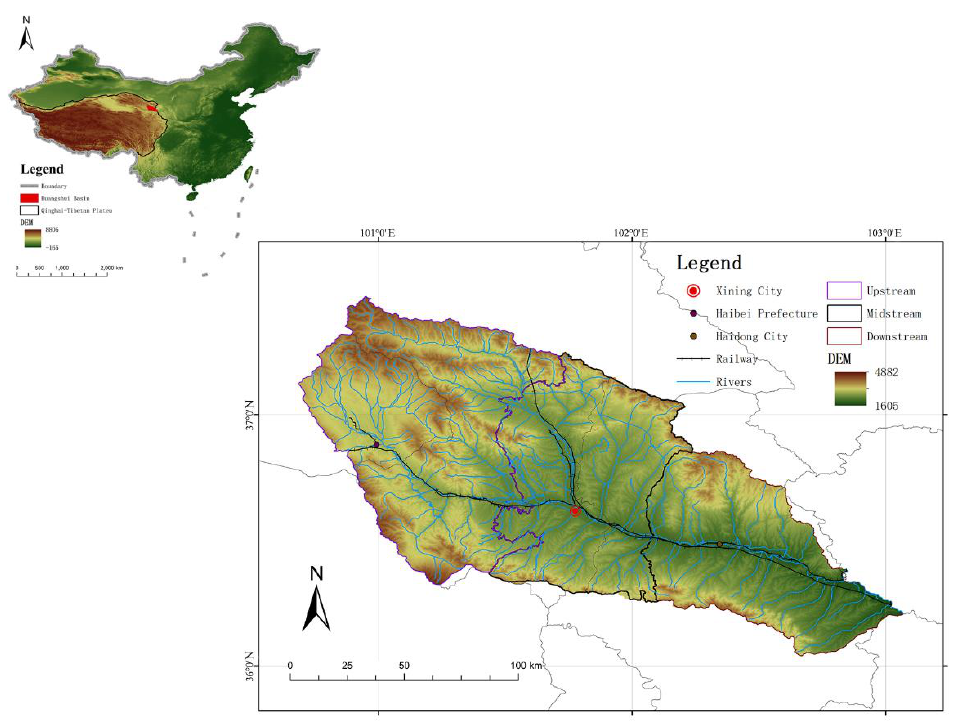
Figure 1. Overview map of the study area ( WGS 84, 1: 1 000 000 ).